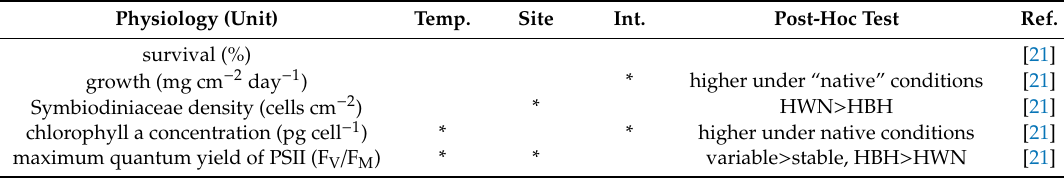
Table 1. A summary of the Seriatopora hystrix variable temperature study . Note that this table reflects a mix of results from published works from the same experiment (see cited references [Ref.].) and this study (“Herein” in the “Ref.” column). When a statistically significant finding (*; p < 0.05) was documented in the prior reference, the results of the post-hoc test(s) have been shown. Only di ff erentially concentrated proteins (DCPs), and not the “proteins of interest” used in model building (described in the Materials and Methods), have been included in the iTRAQ rows. 2DGE = 2-dimensional gel electrophoresis. DEG = di ff erentially expressed genes. GCP = genome copy proportion (a molecular proxy for endosymbiont density). HBH = Houbihu (upwelling site). HWN = Houwan (non-upwelling site). int. = interaction. iTRAQ = isobaric PSII = photosystem II. RNA-Seq = RNA sequencing. RSA = response screening analysis. stab = stable. temp. = temperature. var =